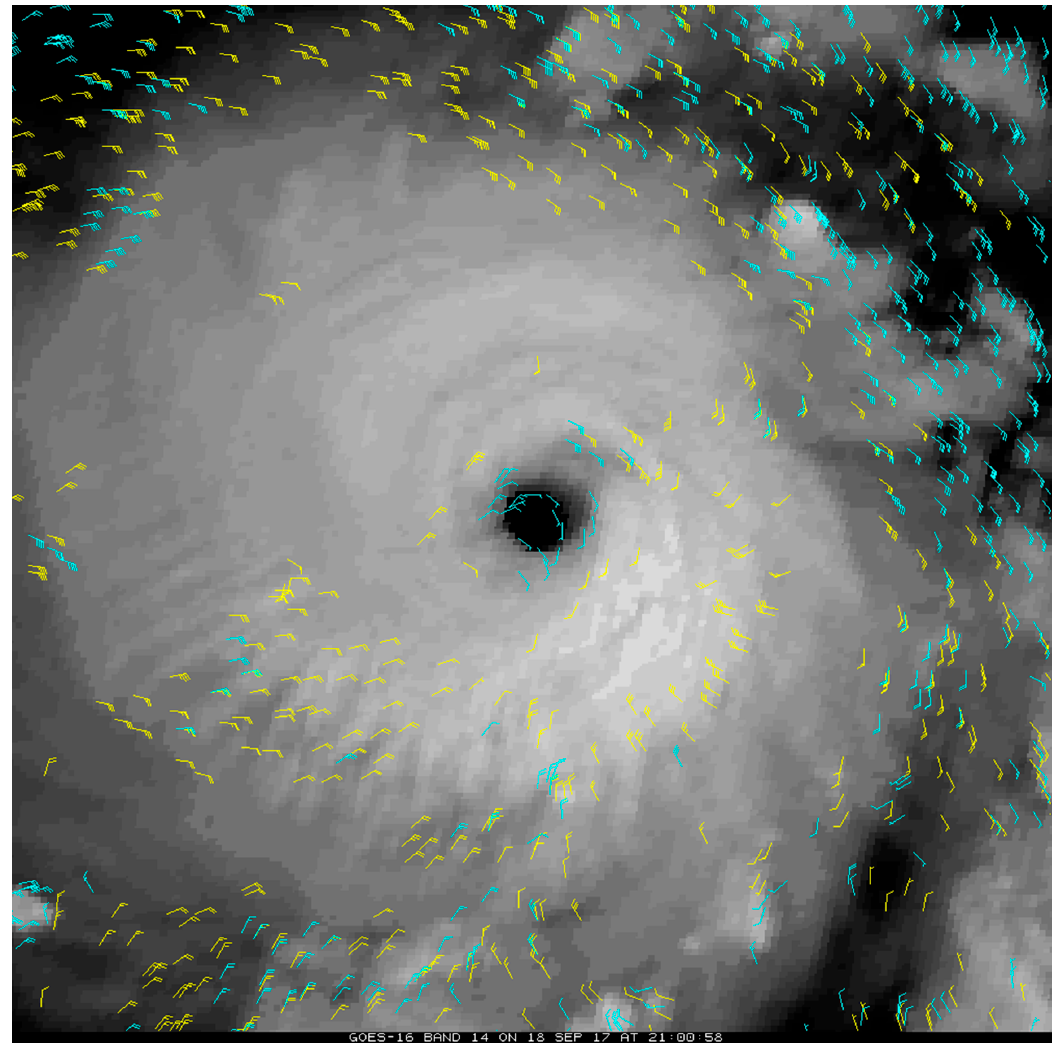
Figure 3. Same as Figure 2, except those yellow AMVs are now plotted in cyan. The yellow AMVs here are those added by modifications to the spatial coherence test and gradient thresholds.